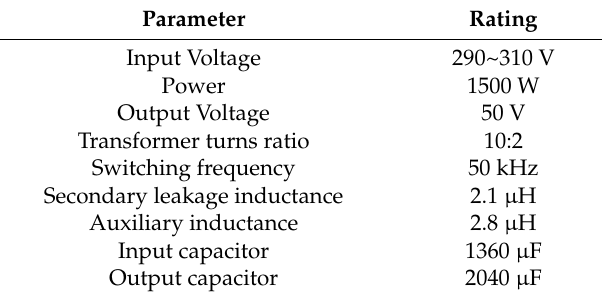
Table 2. DAB-IBDC converter design specifications 1.5 kW.